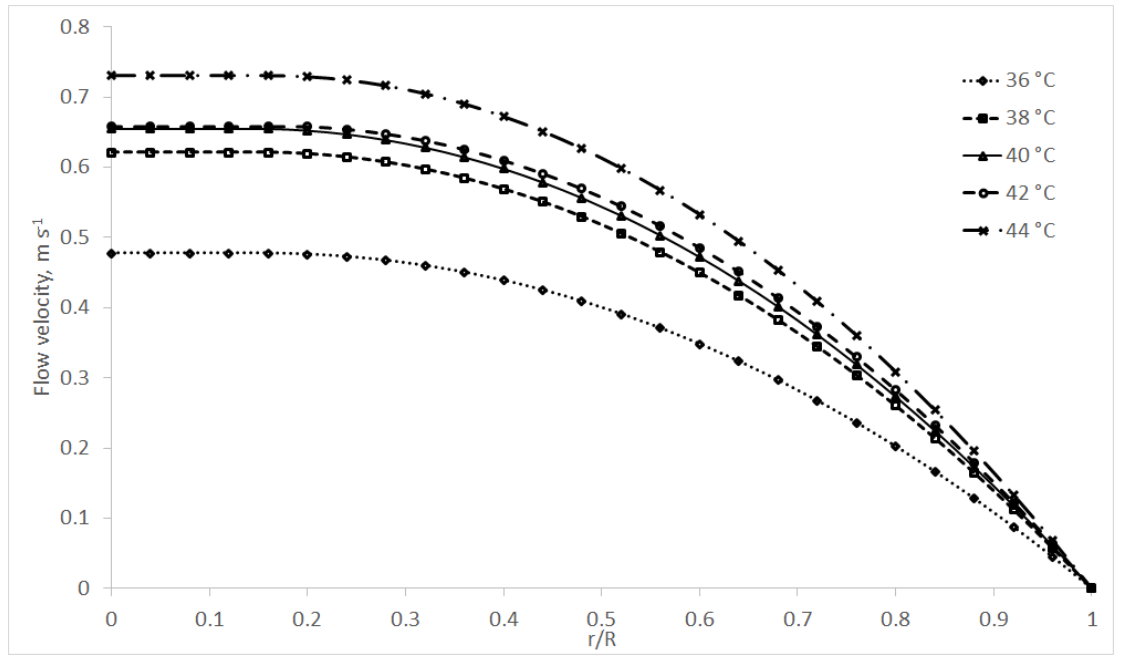
Figure 2. MC velocity profiles at temperatures of 36 – 44 °C using the H – B model.